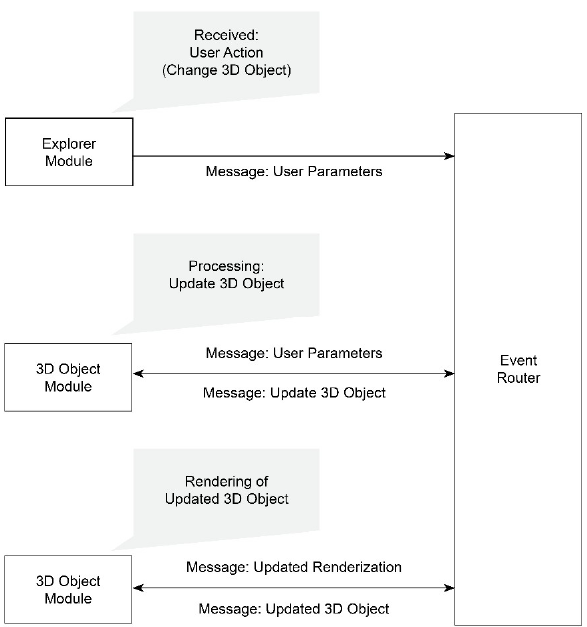
Figure 2. Overview of the event router and event-oriented communications proposed by CW4P. Source: adapted from [10].